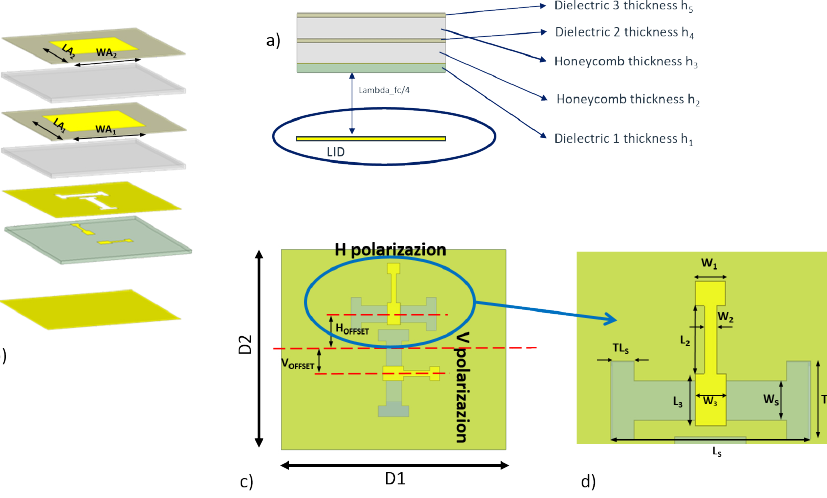
Figure 1. Geometry of the single dual-polarized patch antenna: ( a ) side view; ( b ) exploded view; ( c ) top view of the ground plane with slots and terminal part of the feeding lines; ( d ) Enlargement relative to H